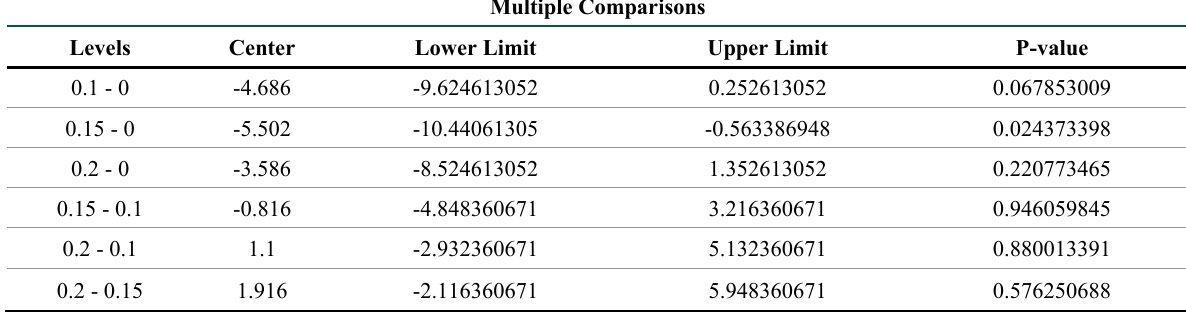
Table 11. Tukey Test of GLR substitution at 28